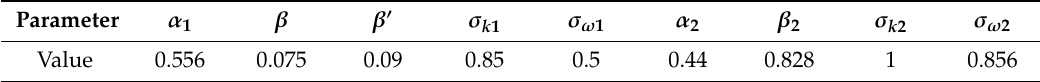
Table 2. Parameter settings of the SST k - ω turbulence